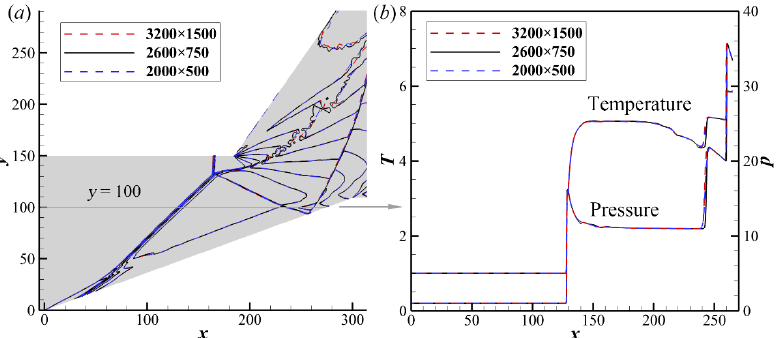
Figure 4. Temperature fields ( a ) and pressure/temperature profiles ( b ) along the line y = 100 in the case of M 0 = 5.5.